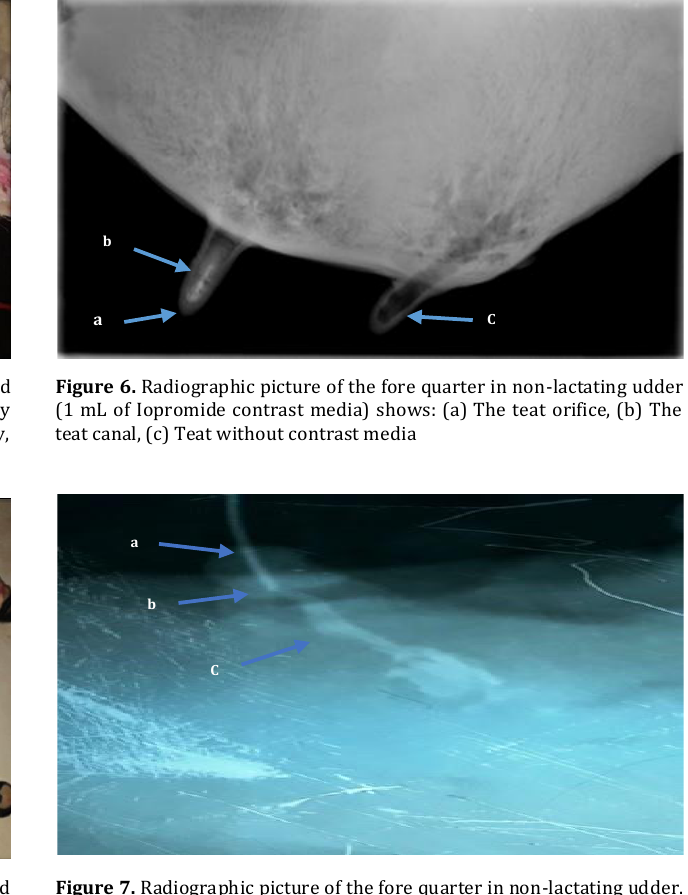
Figure 5. Photograph of Udder of local Iraqi cow with injected blood vessels showing: (a) External Pudendal artery, (b) Branch of supramammary lymph node, (c) Cranial mammary artery